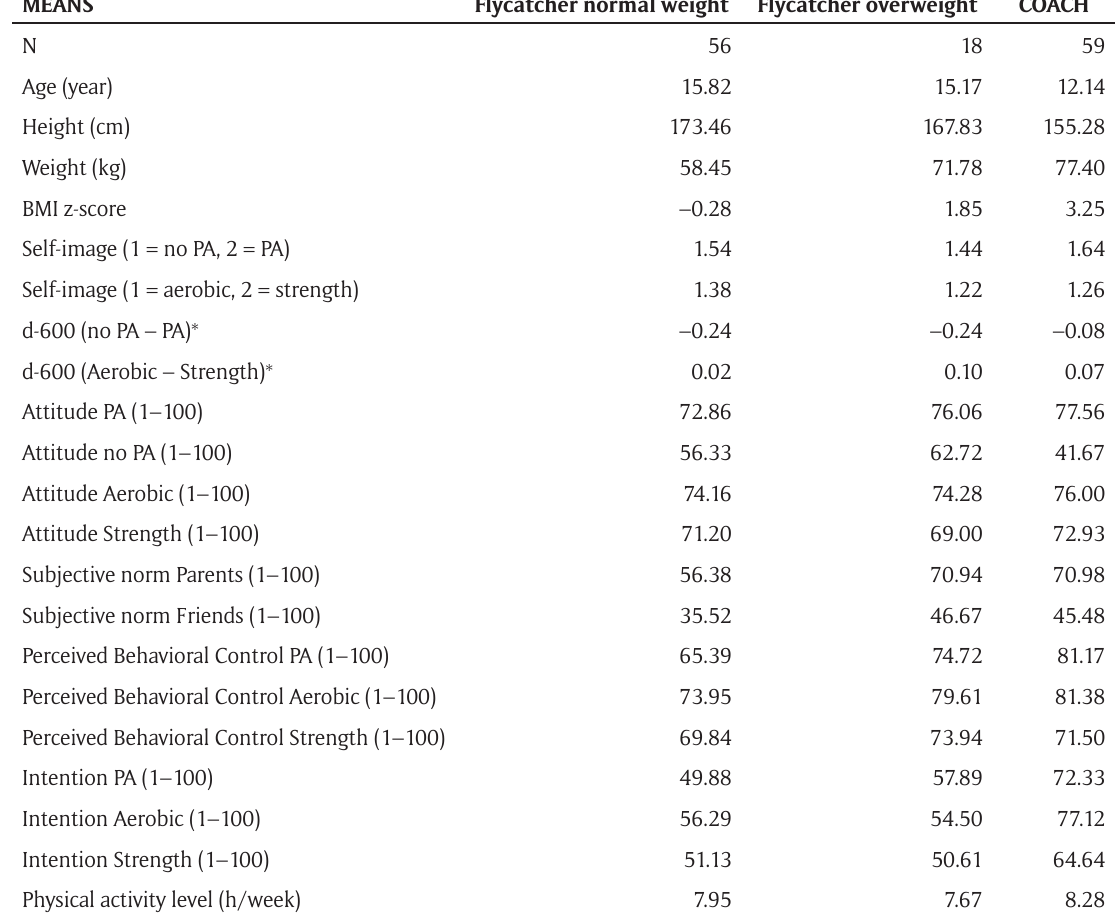
Table 1: Mean Scores of the Flycatcher Subsamples, and the COACH Sample, as a Crude Approximation of Matching. MEANS Flycatcher normal weight Flycatcher